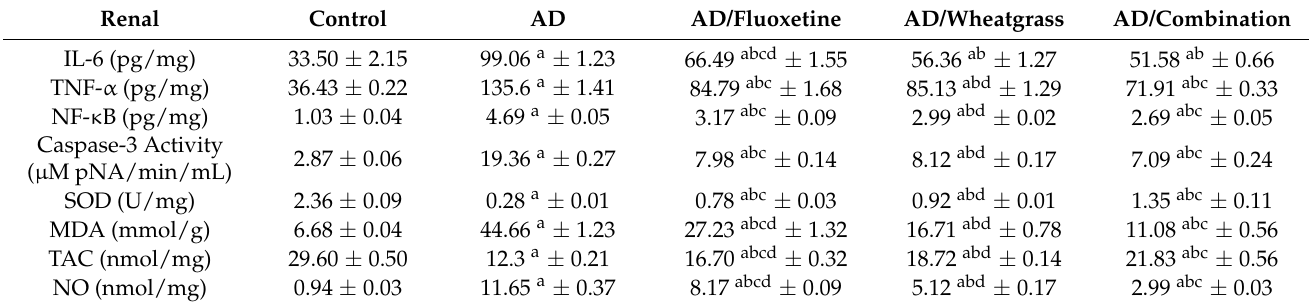
Table 4. Effects of fluoxetine, wheatgrass, or their combination on renal interleukin-6 (IL-6), tumor necrosis factor- α (TNF- α ), nuclear factor kappa B (NF- κ B), caspase-3, malondialdehyde (MDA), nitric oxide (NO), superoxide dismutase (SOD), and total antioxidant capacity